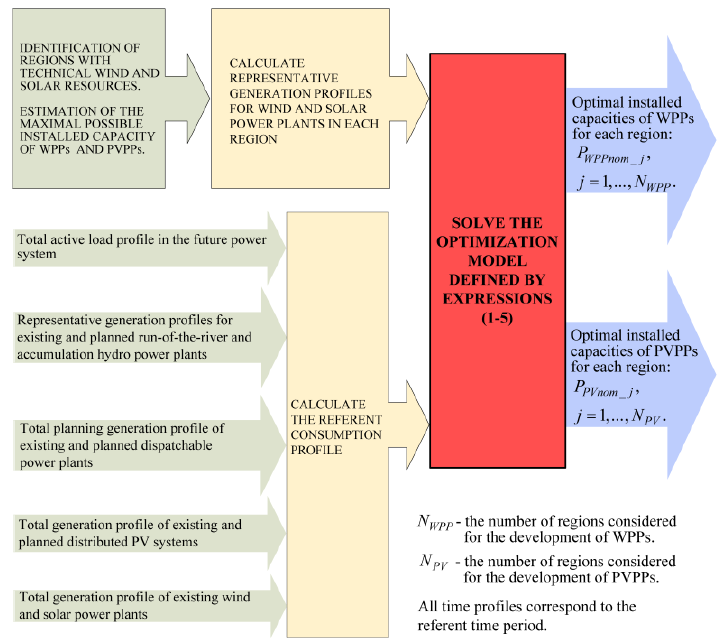
Figure 1. The proposed algorithm for planning RES development for complete decarbonization of electrical energy generation.